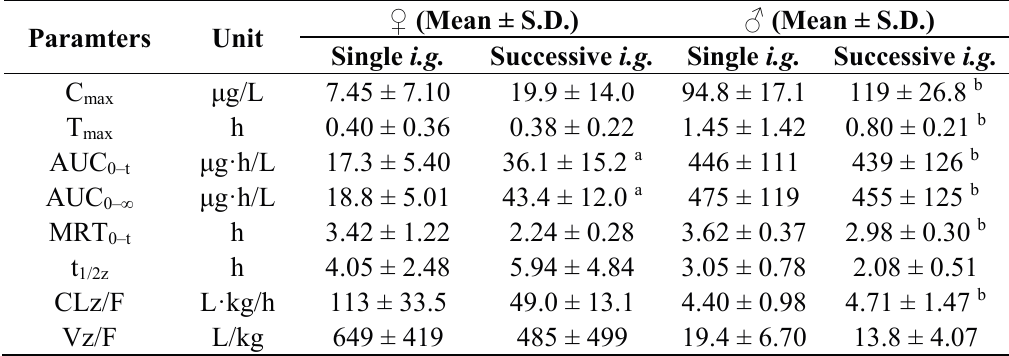
Table 2. Pharmacokinetic parameters of verticinone after single and successive i.g. administration of 2 mg/kg to SD rats ( n =